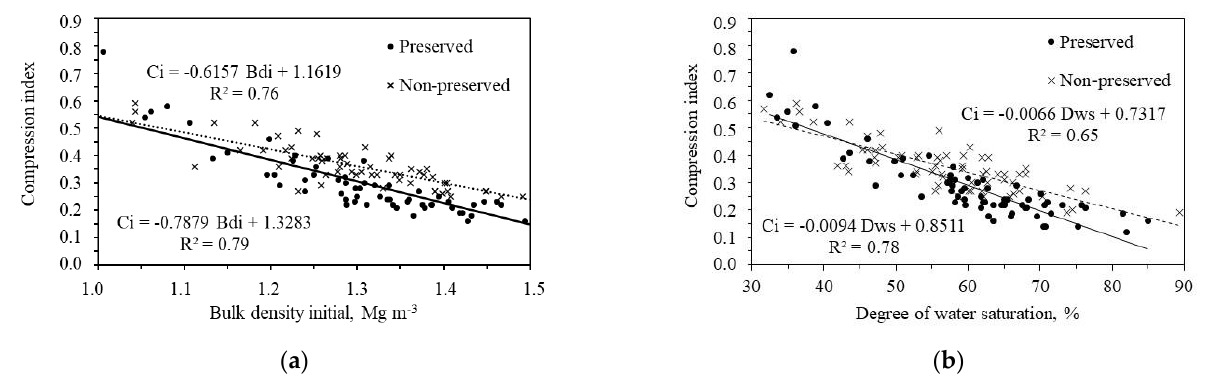
Figure 7. Regression between physical properties for soil with preserved and non-preserved structure. Bdi = bulk density in the beginning of the uniaxial compression test; Dws = degree of water saturation; Ci = compressibility index.